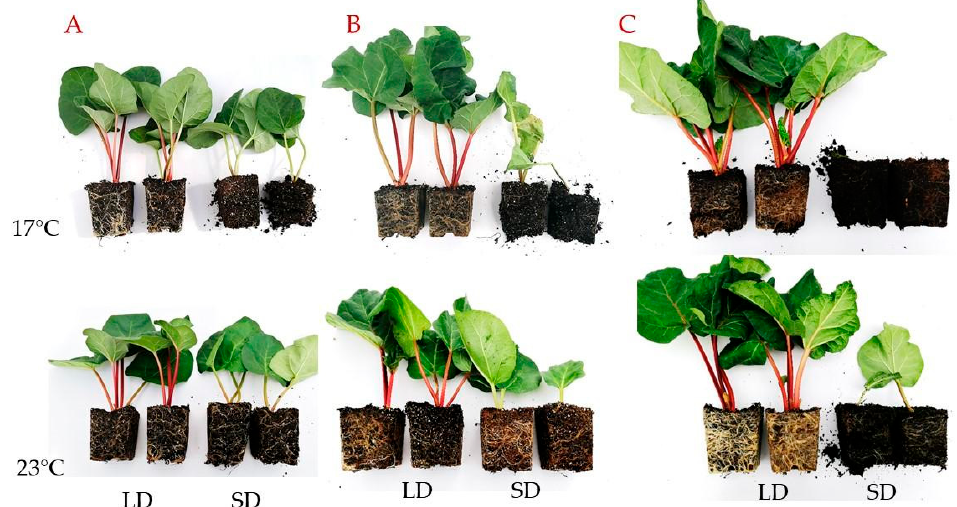
Figure 2. Phenotypic characteristics of the rhubarb ‘Raspberry’ plantlets after different growth periods (( A )—2 months, ( B )—3 months, ( C )—4 months) in the growth room under different temperatures (17 °C and 23 °C) and photoperiods (16 h and 10 h); LD—long day, SD—short day.